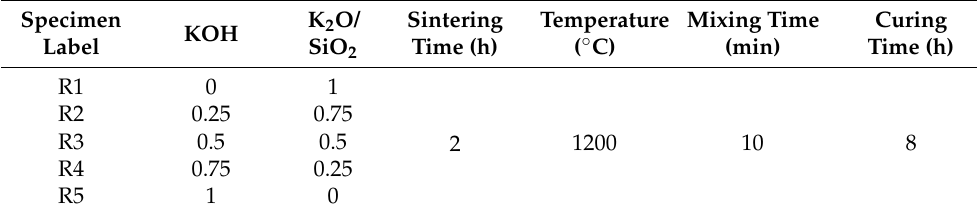
Table 2. Mixing proportion at different alkaline solution ratios.